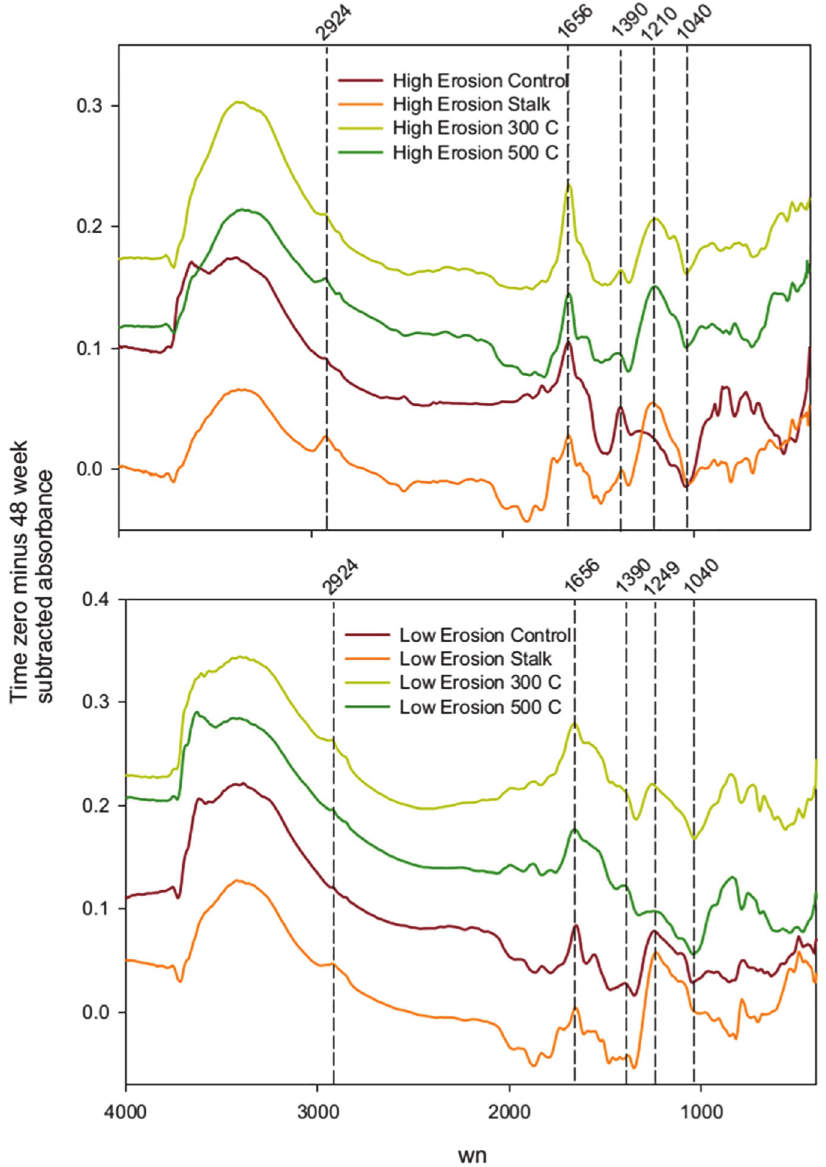
Fig 4. Spectral subtraction of the mid infrared spectra from the unamended soil controls, soil plus stalk feedstock, soil plus 300 degree biochar, and soil plus 500 degree biochar treatments. Subtractions are time zero spectra minus 48 wk incubation soil spectra. Top graph is the High-erosion Soil, and bottom graph is the Low-erosion Soil. wn = wavenumbers in cm -1